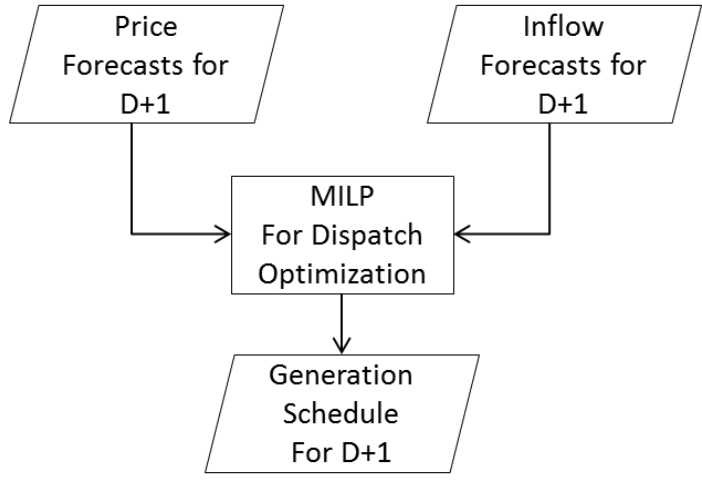
Fig. 3. Dispatch model